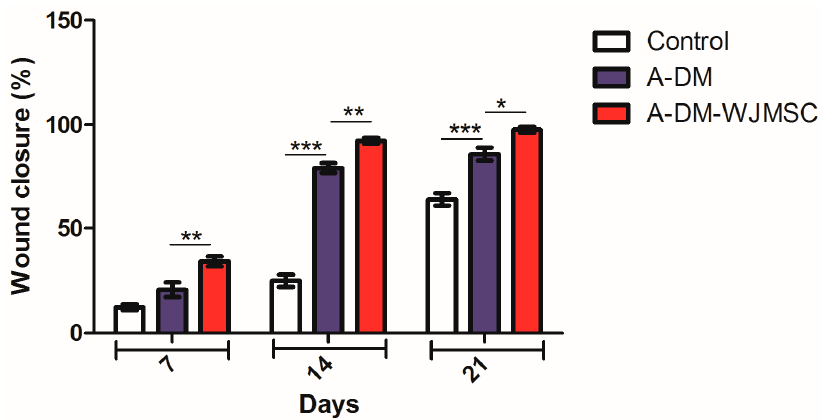
Figure 5. Wound closure rates were quantitatively calculated by image analysis of photographs at different time points (* p < 0.05, ** p < 0.01, *** p <